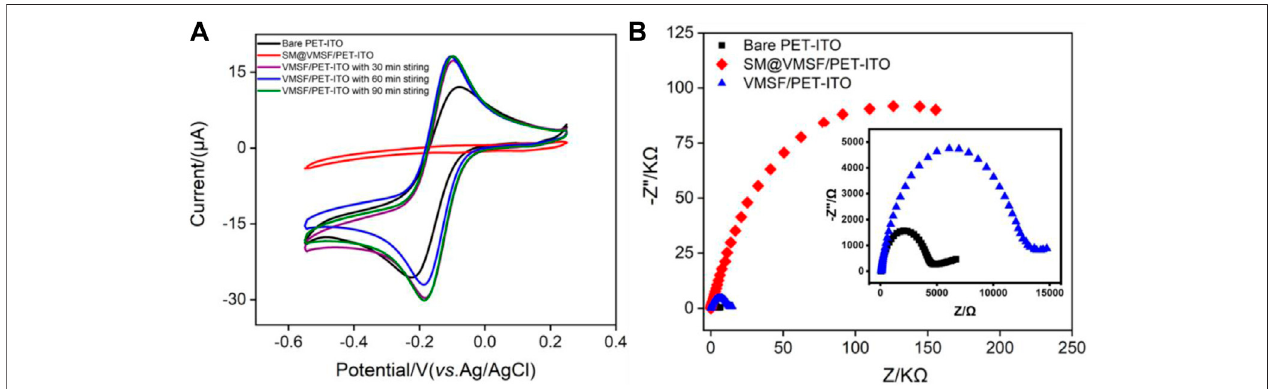
FIGURE 2 | (A) Cyclic voltammetry (CV) curves on bare PET-ITO, VMSF/PET-ITO, or SM@VMSF/PET-ITO electrodes in Ru (NH 3 ) 63+ solution (0.5 mmol/L in 0.05 mol/LKHP).TheVMSF/PET-ITOelectrodewaspreparedthroughtheremovalofSMusingdifferentsoakingtimewithstirringinacetoneasindicated. (B) EIScurves obtained on are PET-ITO, VMSF/PET-ITO, or SM@VMSF/PET-ITO in [Fe(CN) 6 ] 3 − /4 (2.5 mmol/L in 1 mol/L KCl). Inset in (B) is the magni fi ed plots of bare PET-ITO and